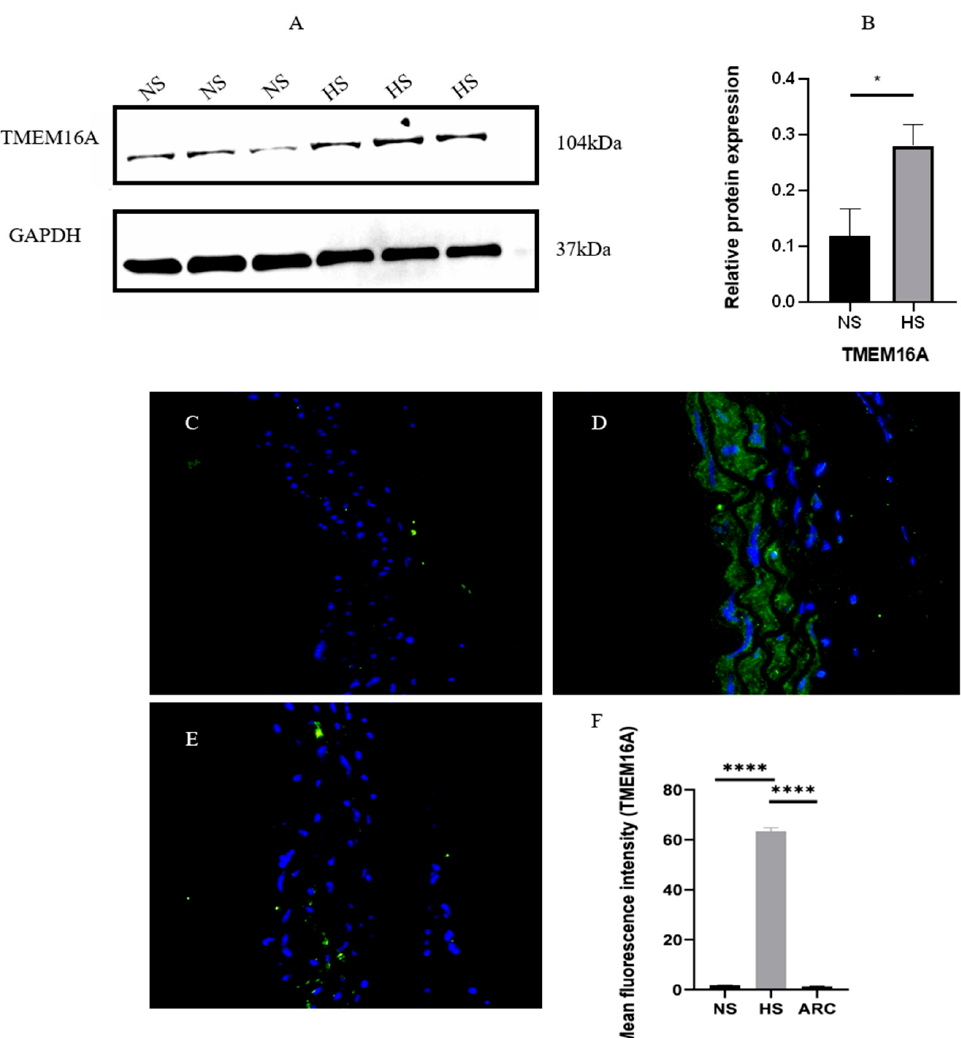
Figure 3. ( A ) Western blot analysis indicated increased expression of TMEM16A in the HS group compared with NS group. ( B ) Relative level of TMEM16A protein expression. Data are expressed as mean ± SD, * p < 0.05, t ‐ test ( n = 3). ( C – E ) Representative images of TMEM16A (green) immunofluorescence in thoracic aortas in the NS group, HS group, and HS+ARC100 groups ( n = 4). Scale bar:50 μ m; blue represents nucleus. ( C ) NS group; ( D ) HS group; ( E ) HS+ARC100 group. ( F ) Mean fluorescence was quantified using one ‐ way ANOVA and p ‐ value adjusted for multiple comparisons with Sidak multiple ‐ comparison test ( n = 4), **** p < 0.0001. NS: normal salt group, HS: high ‐ salt group, HS+ARC: HS+ arctigenin (100 mg/kg) group.